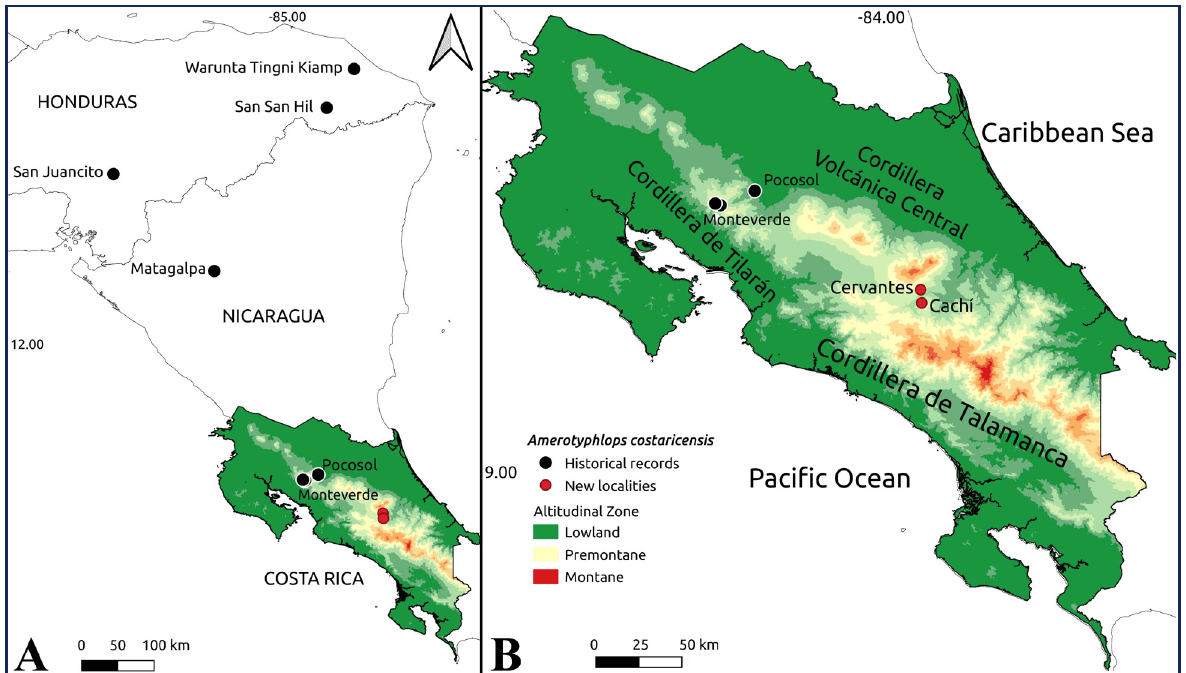
Figure 1. Published locality records of Amerotyphlops costaricensis . A. Historically recorded localities in Central America. B. New records for the species in Costa Rica, their relationship with the main mountain systems, and with the other historical localities in the country (Table 1).